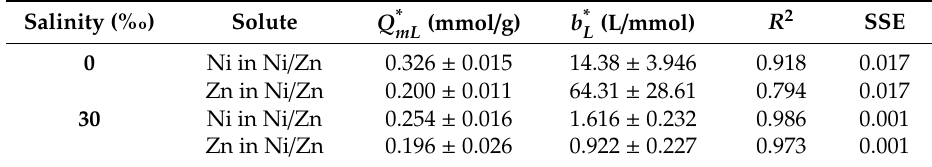
Table 7. Comparison of Q mL and b L values of single and binary adsorption of Ni and Zn at pH 5. / Q * Q mL , Ni / Q * Q mL , Zn / Q * Salinity (% (cid:24) ) Q mL,Ni / Q mL,Zn Q * mL , Zn mL , Zn mL , Ni mL , Ni 0 1.219 1.630 0.851 0.637 30 2.175 1.297 0.798 1.338 / b * b L , Ni / b * b L , Zn / b * Salinity (% (cid:24) ) b L,Ni / b L,Zn b * L , Zn L , Zn L , Ni L , Ni 0.955 0.224